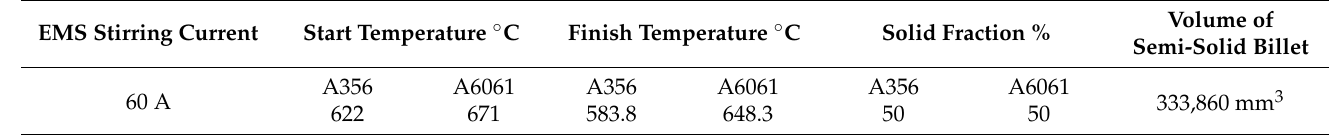
Table 2. Experiment conditions of rheo